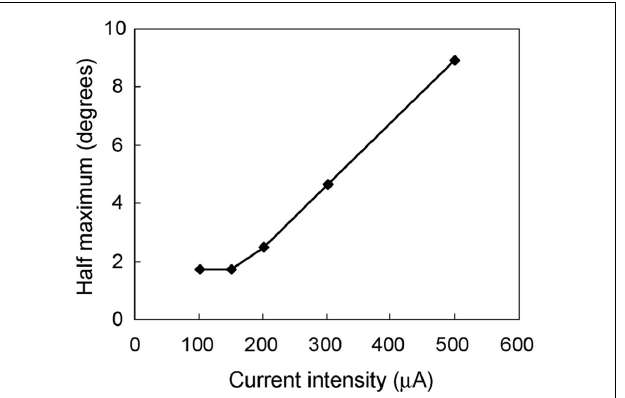
FIGURE 5 | The relationship between the spatial extent of the neural response and the stimulus current intensity. The half width at half maximum was calculated from the median-distance graphs in Figure 4 . The half width decreased following a decline in stimulus intensity from 500 to 150 µ A. However, the half width was constant at 1.8 ◦ from 150 to 100 µ A.